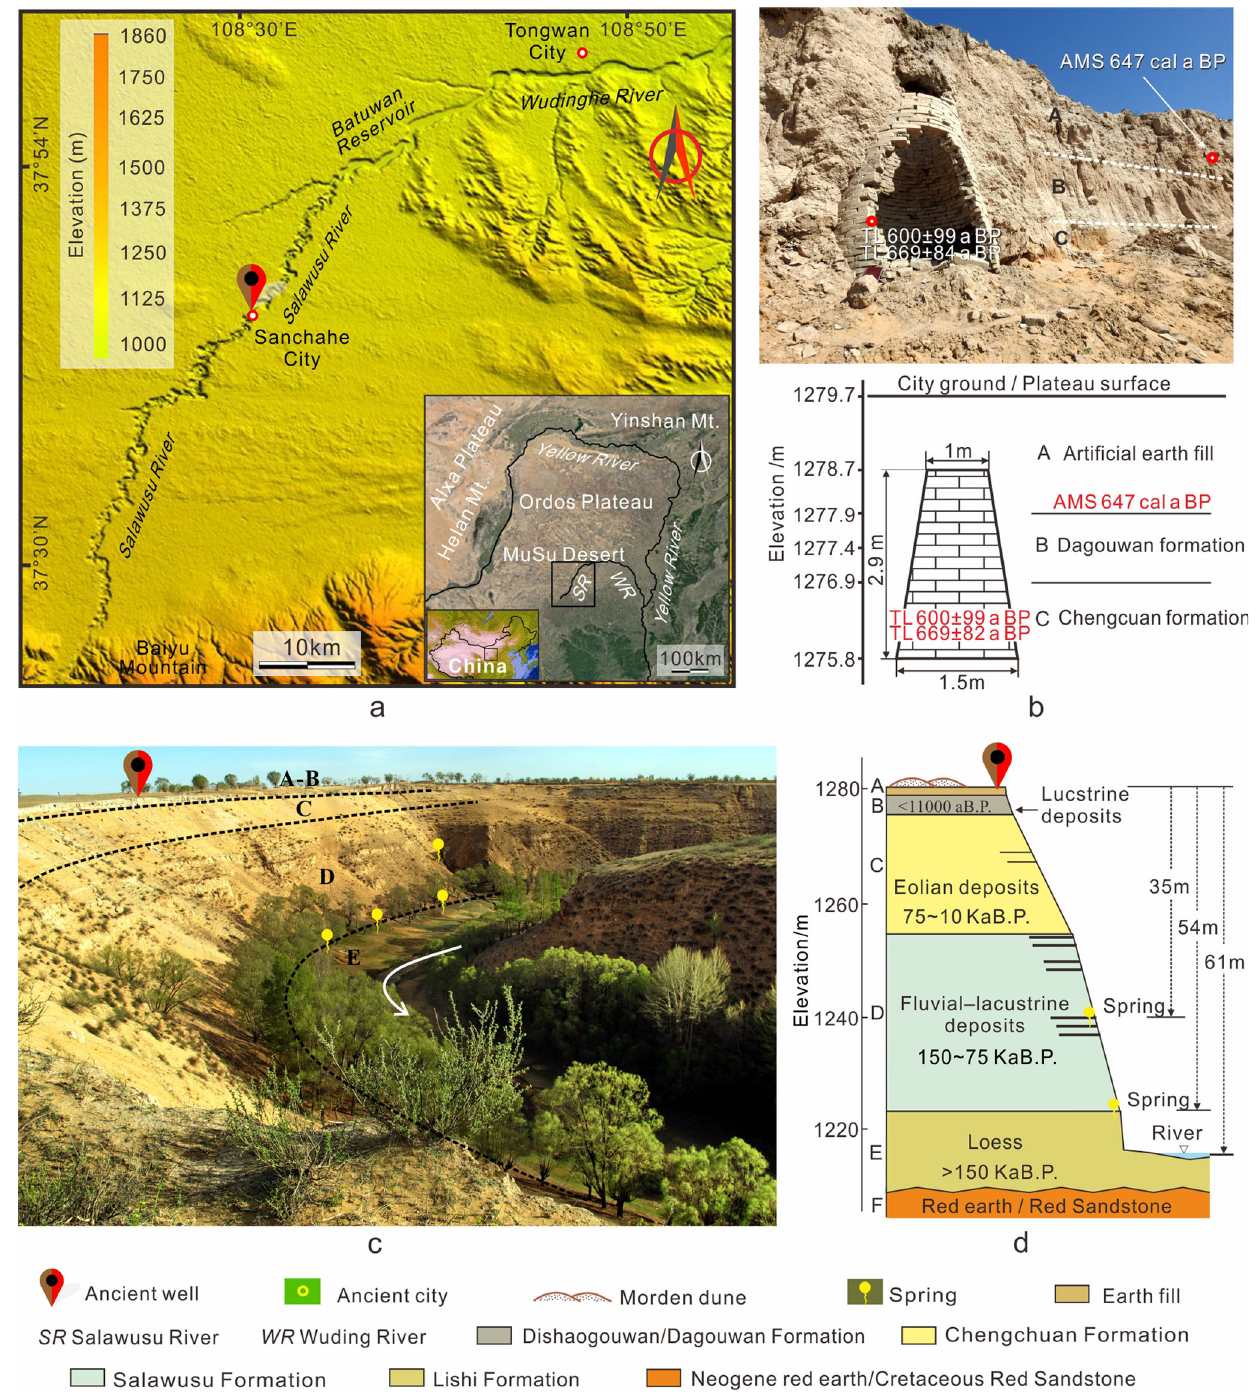
Fig. 1 Location of the abandoned well and Sanchahe City and the strata of the study area. a Map showing locations of the Salawusu River, Wuding River, and Sanchahe City in the Mu Us Desert. b Field photograph of the abandoned well and diagram showing altitudes of the abandoned well and the strata next to the well coupled with the TL ages of the well bricks and the AMS median calibrated age of the charred dust in the arti fi cial earth- fi ll above strata. c Field photograph of the Salawusu Valley and location of the ancient well. d Diagram showing vertical distance from the well to the valley bed and strata present on the side of the